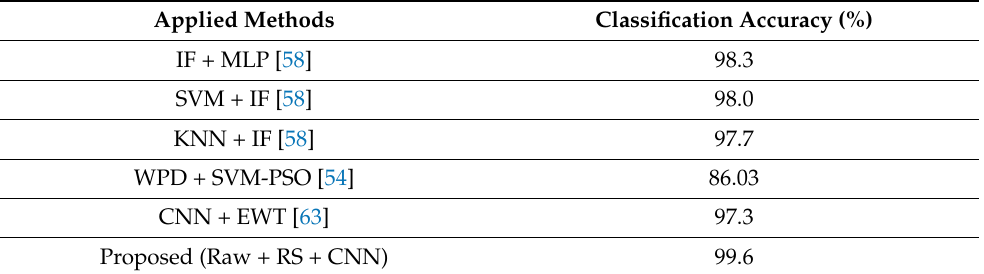
Table 7. Comparison of accuracy metrics with existing